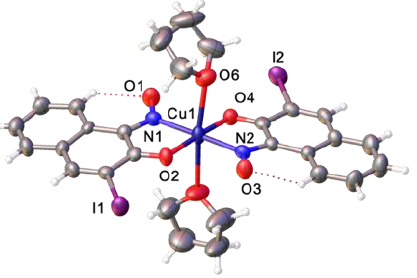
Figure 3. View of the molecular structure of 3 obtained from XRD study. Only one from two symmetrical, independent molecules 3 is given for the sake of simplicity. Nonhydrogen atoms are given as probability ellipsoids of atomic displacements ( p = 0.5).